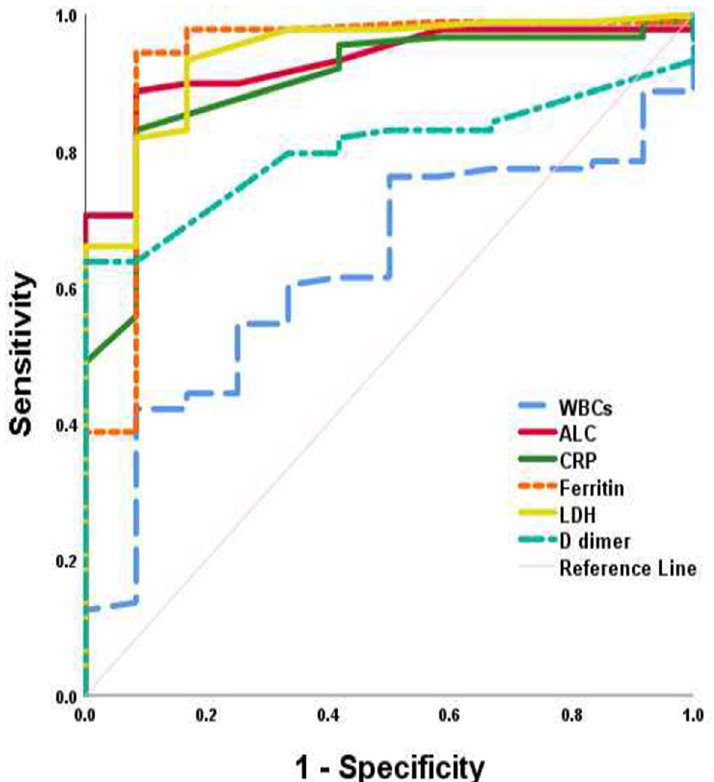
Fig. 2 ROC curve of TLC, ALC, CRP, ferritin, LDH, and D‑dimer for discrimination between negative and positive